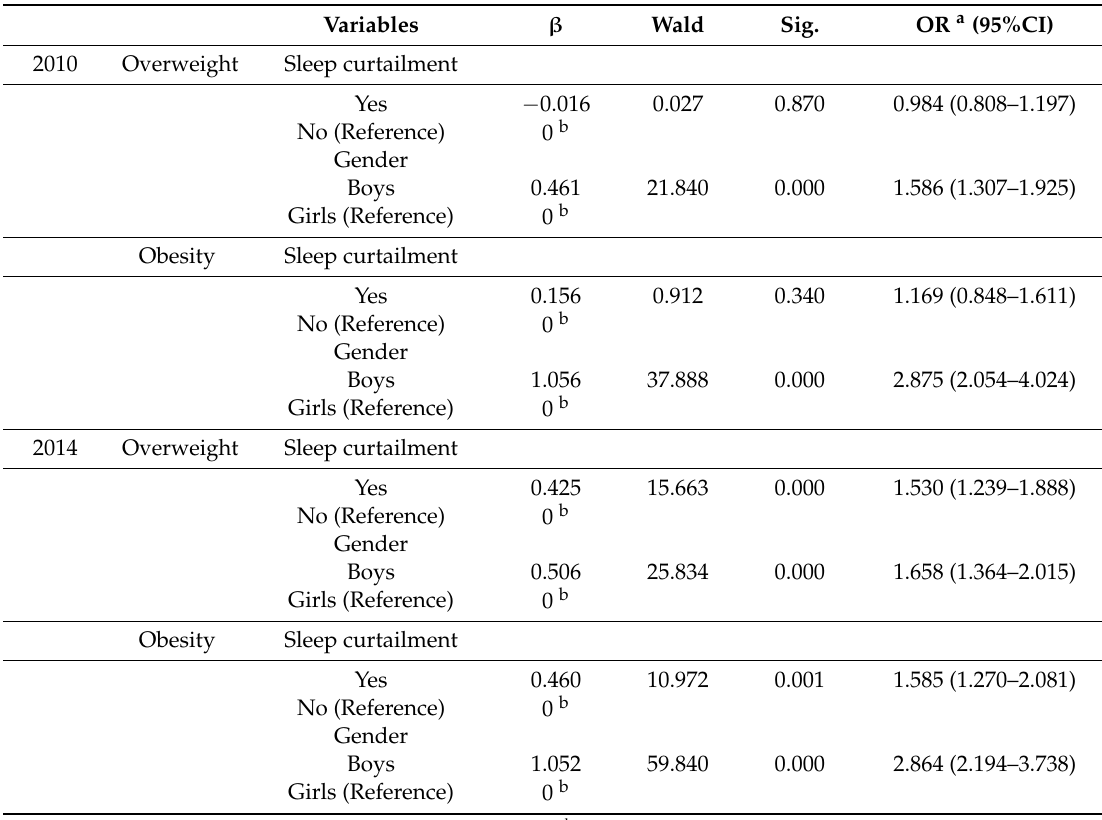
Table 9. Association between sleep curtailment and overweight or obesity stratified by age group in 2010 and 2014 (16–18-year age